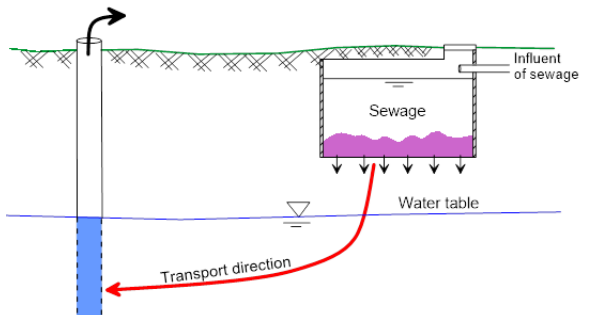
Fig. 1. Diagram of sewage percolation and transport from the septic tank to pumping